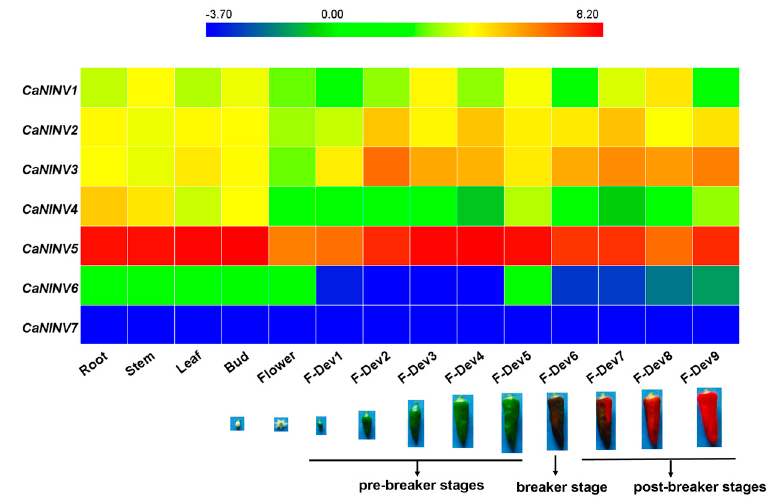
Figure 8. Expression profiles of seven pepper CaNINV genes for different tissues and developmental stages. The expression data were collect from the Illumina RNA-seq data obtained by pepper (cultivar Zunla-1) genome sequencing [30]. The images of the developmental stages of pepper fruit were cited from Qin et al. [30]. The FPKM values were log 2 transformed and the heat map was generated using HemI (Heatmap Illustrator, version 1.0) software package. Bar at the top represents log 2 -transformed values. Genes highly or weakly expressed in the tissues are colored blue and red, respectively.